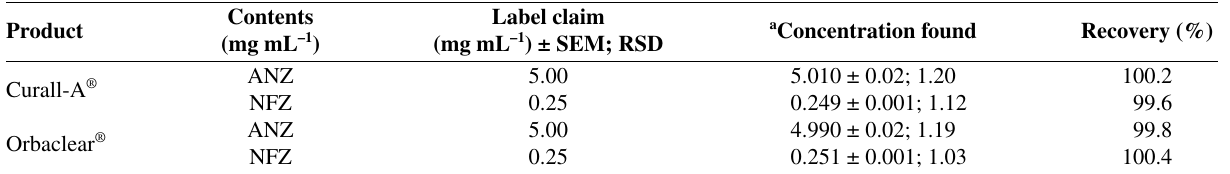
Table 8. Assay result of ANZ and NFZ by UHPLC in commercial ophthalmic formulations